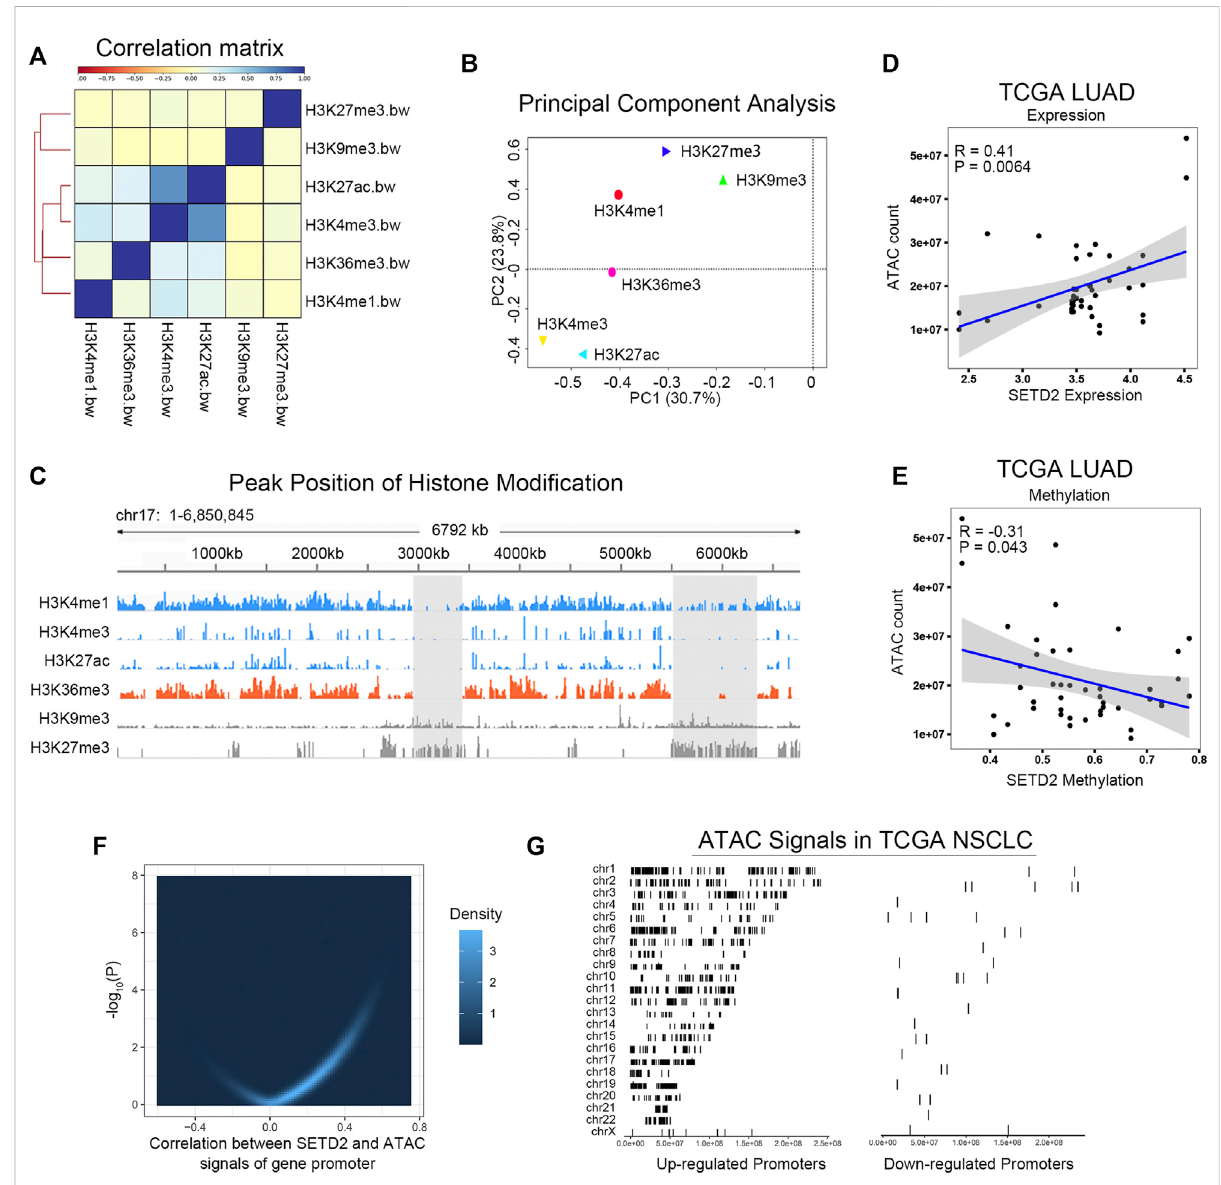
FIGURE 3 SETD2andH3K36me3enhancedchromosomal accessibility. (A) Correlation analysis ofH3K36me3andotherhistonemodi fi cations. (B) PCAof H3K36me3 and other histone modi fi cations. (C) Peak distributions in chromosome 17: 1-6850845 of H3K36me3 and other histone modi fi cations. (D,E) CorrelationbetweenSETD2andATACsignalsinTCGALUAD. (F) CorrelationbetweenSETD2expressionandtheaccessibilityofthewholegene promoters. (G) The left side shows the location of the ATAC-seq signal of genes whose promoter region accessibility is positively correlated with SETD2 on the chromosome; The right side shows the position of the ATAC-seq signal of the negatively related gene on the